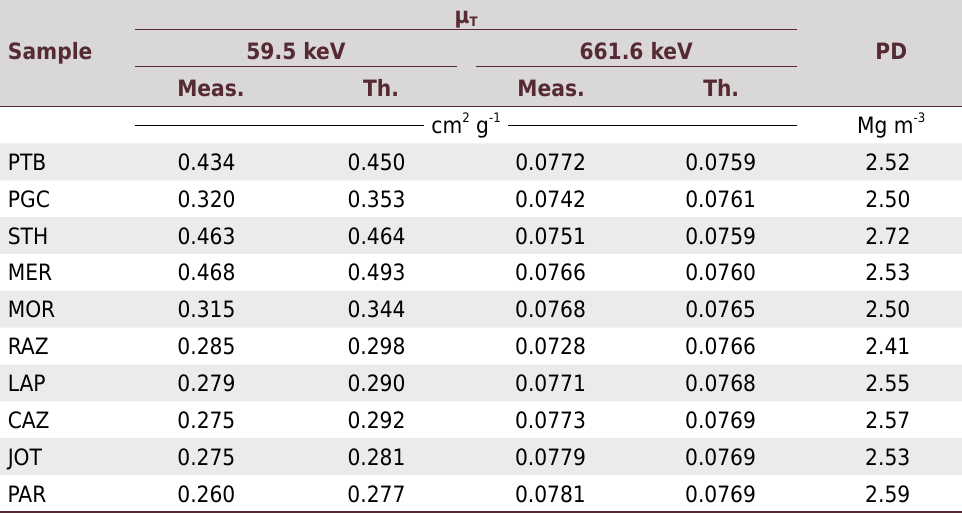
Meas. and Th. stand for the measured and theoretical (calculated)